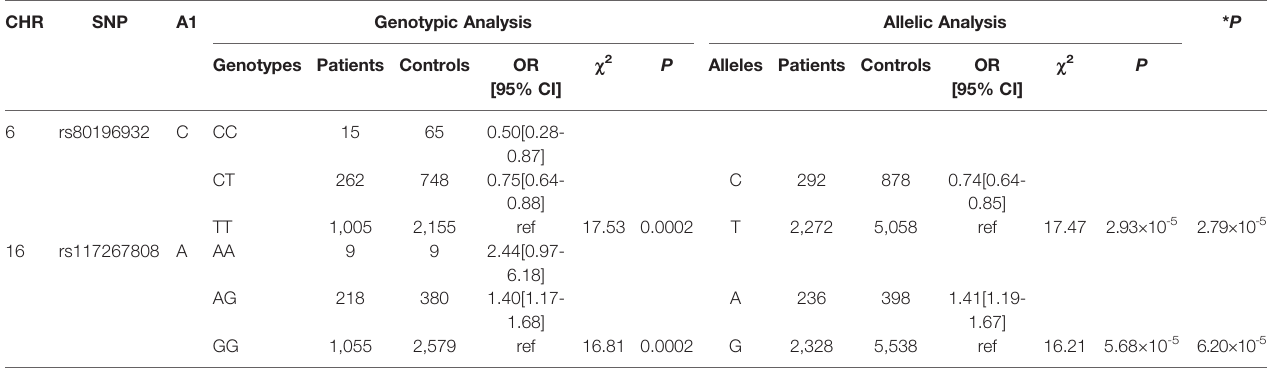
TABLE 2 | Signi fi cant results for single marker based association analyses.